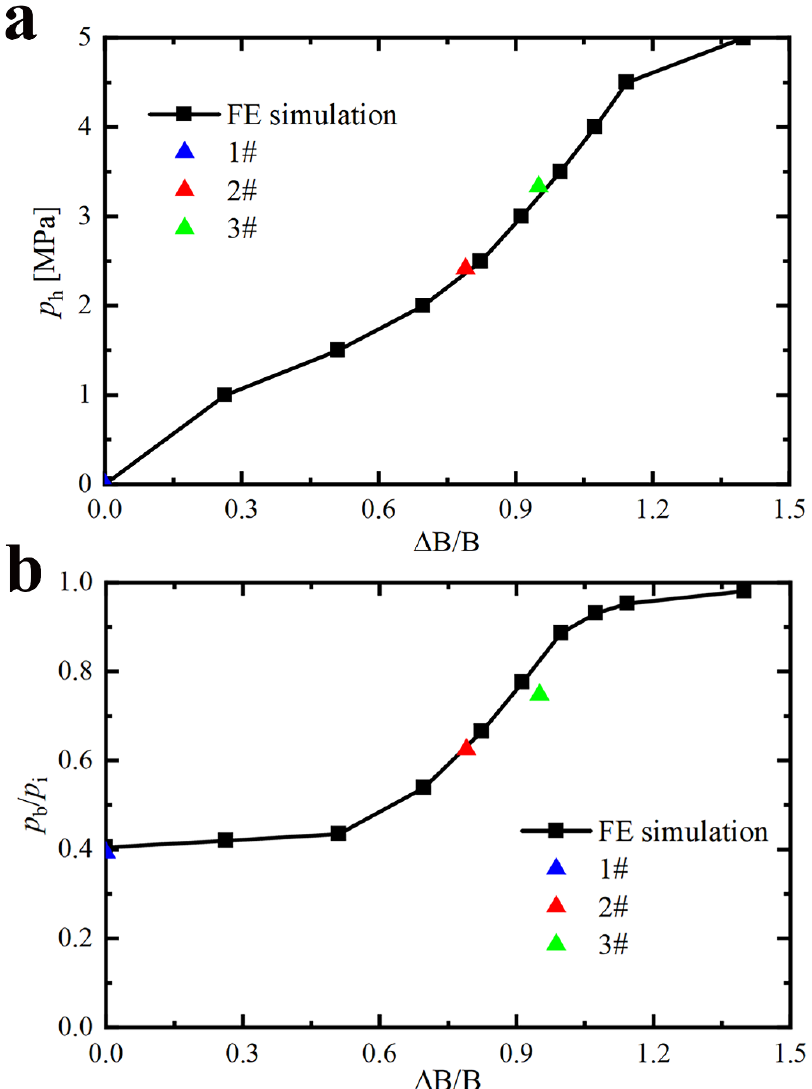
Figure 9. Internal hydroforming pressures ( a ) and external collapse strengths ( b ) of toroidal pressure hulls under various hydroforming amplitudes ( ∆ B ); hydroforming amplitudes ( ∆ B ) are depicted in Figure 5. # is the number of the pressure hulls.